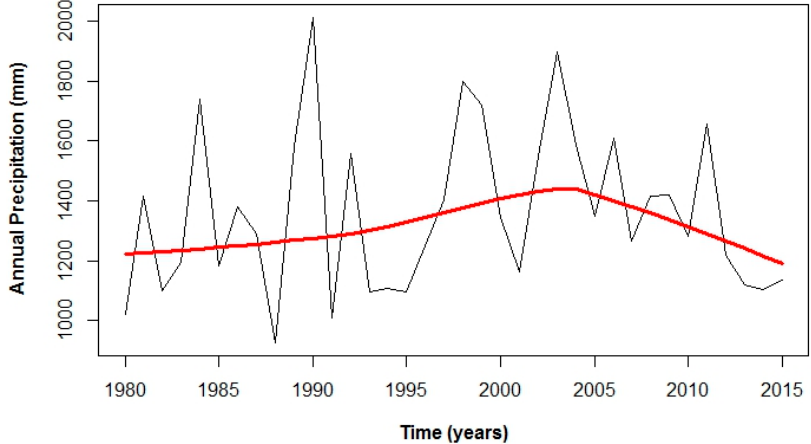
Figure 2. Annual precipitation trend at Sokcho station from 1980 to 2015. Table 1. Statistical summary of the hydro-meteorological and location variables for the 55 stations selected for cluster analysis.